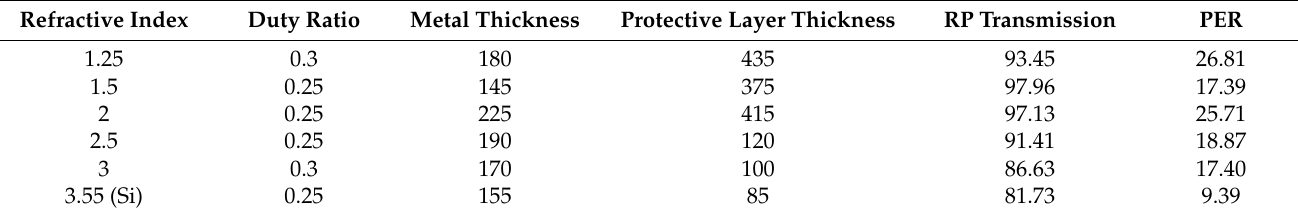
Figure 7. The component transmission of the protective layer applied MSCRA for various materials in terms of protective layer thickness. Table 1. Optimized results of the protected MSCRA structure of various